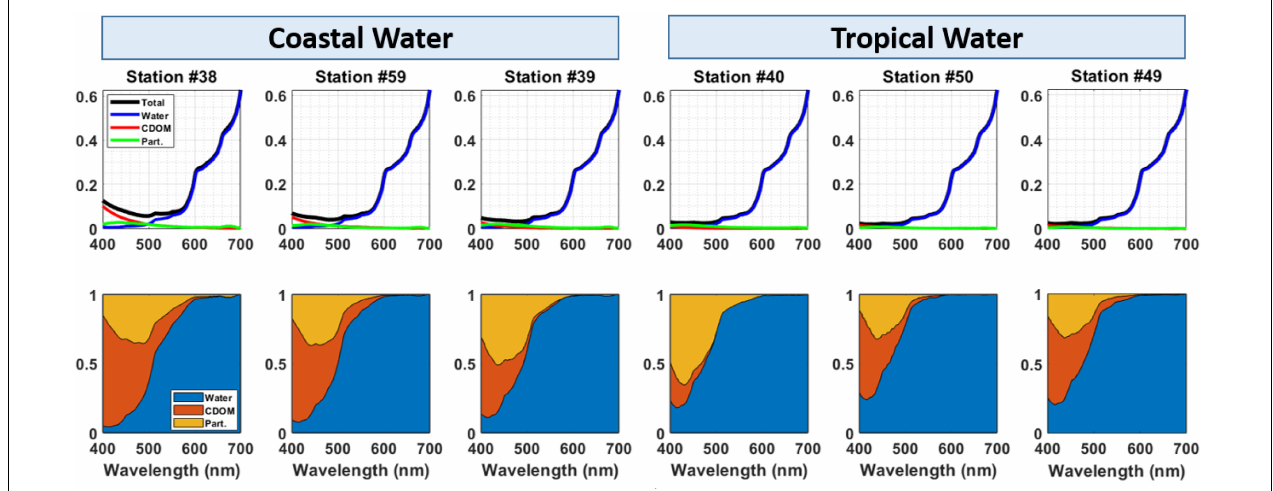
FIGURE 6 | Absorption coefficient spectra (m – 1 ) at the surface for water (blue), CDOM (red), particles (Part., green) and total absorption (black). Surface relative contributions of water (blue), CDOM (red) and particles (Part., orange) to total absorbance in the PAR range (400—700